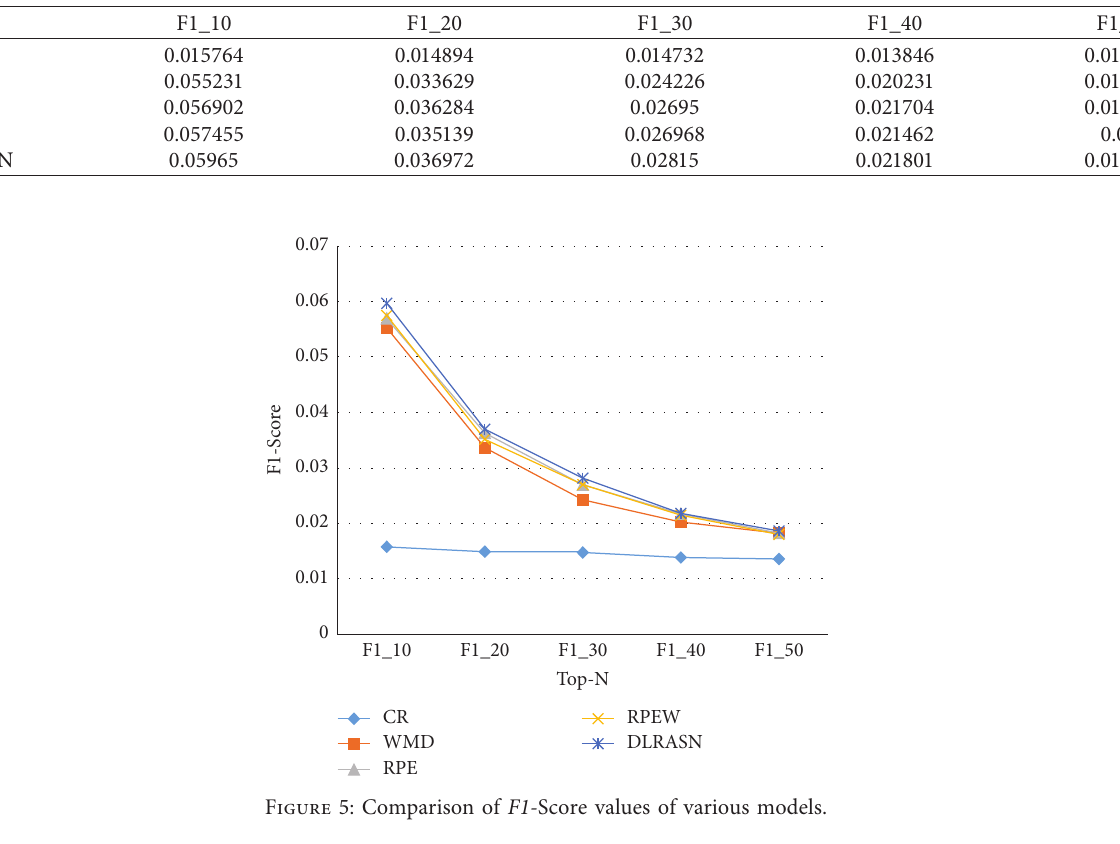
Table 4: Experimental results of F1- Score.